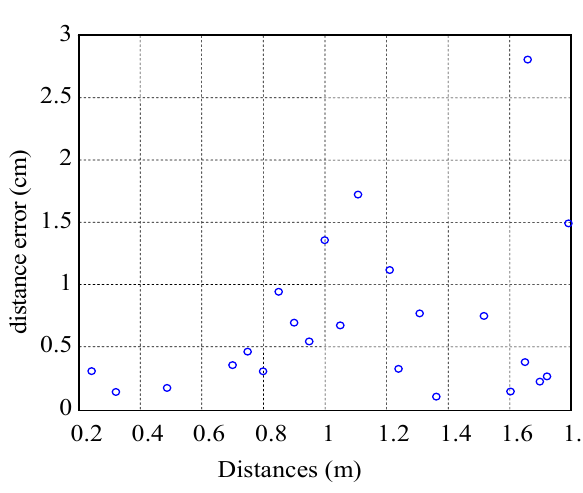
Figure 3. Estimated distance